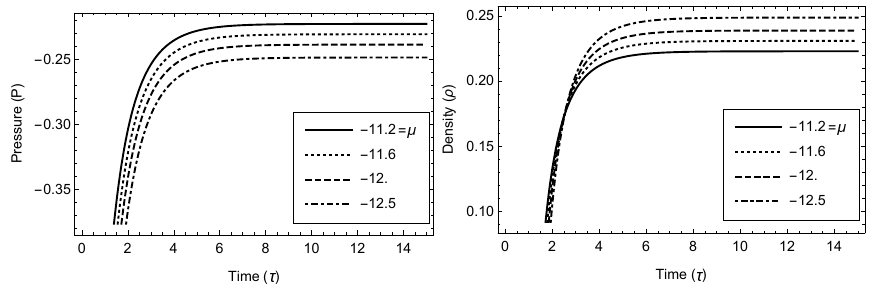
Figure 3. Variation of the pressure and density w.r.t. time (Case